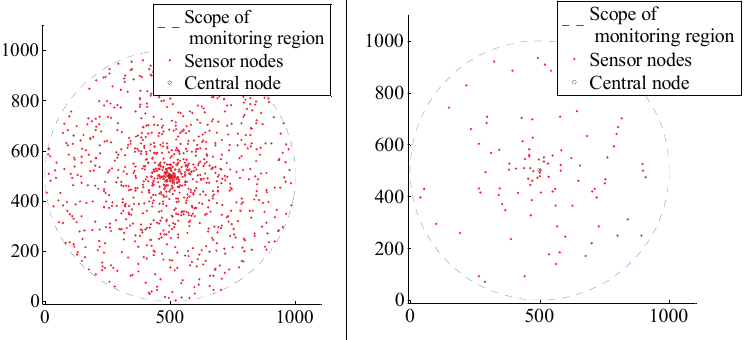
Figure 1. The left figure has 1000 sensor nodes. The right one has 100 sensor nodes.